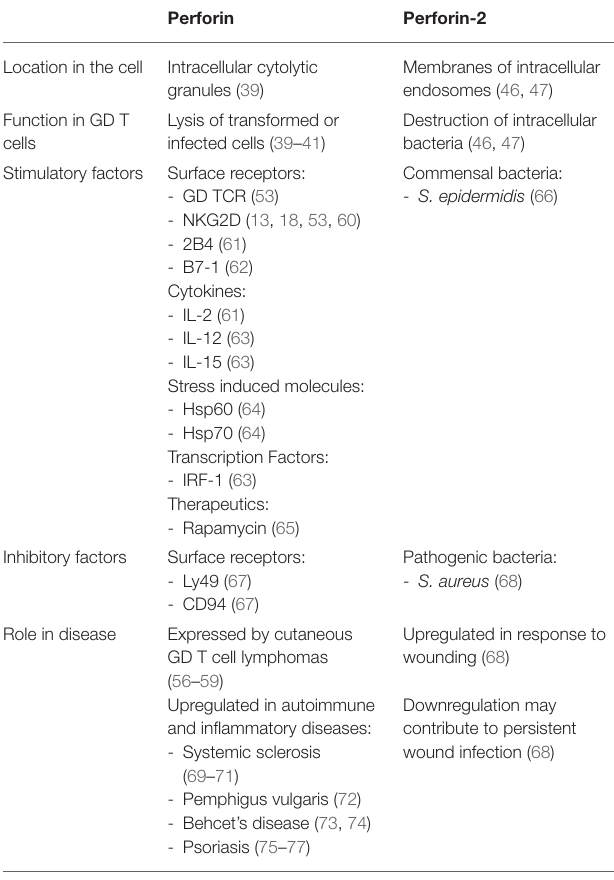
TABLE 1 | Perforins expressed by cutaneous GD T cells. Perforin